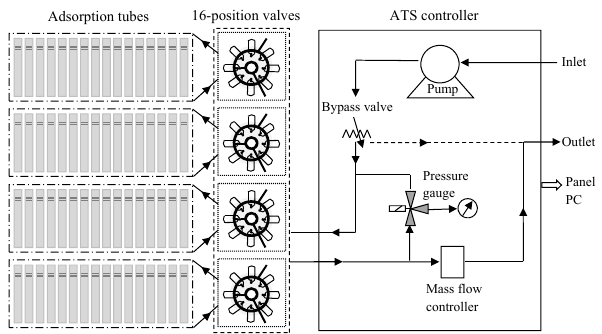
Figure 1. PFC release unit: schematic of gas flow (left); aircraft release module (right). Figure 1. PFC Release Unit: Schematic of gas flow (left); Aircraft release module (right). 603 trolling the solenoid valves (Fig. 1 (left), solenoid valve 1).